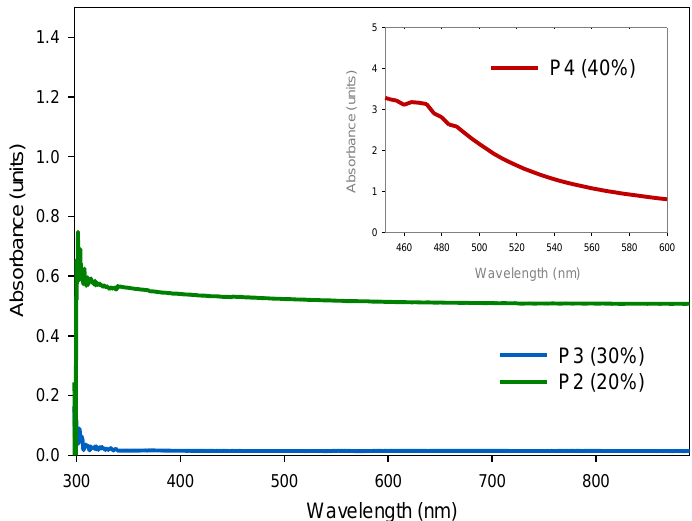
Figure 17. UV-Vis spectrums of P2 (20%) (Green line), P3 (30%) (Blue line) and P4 (40%) (Red line).